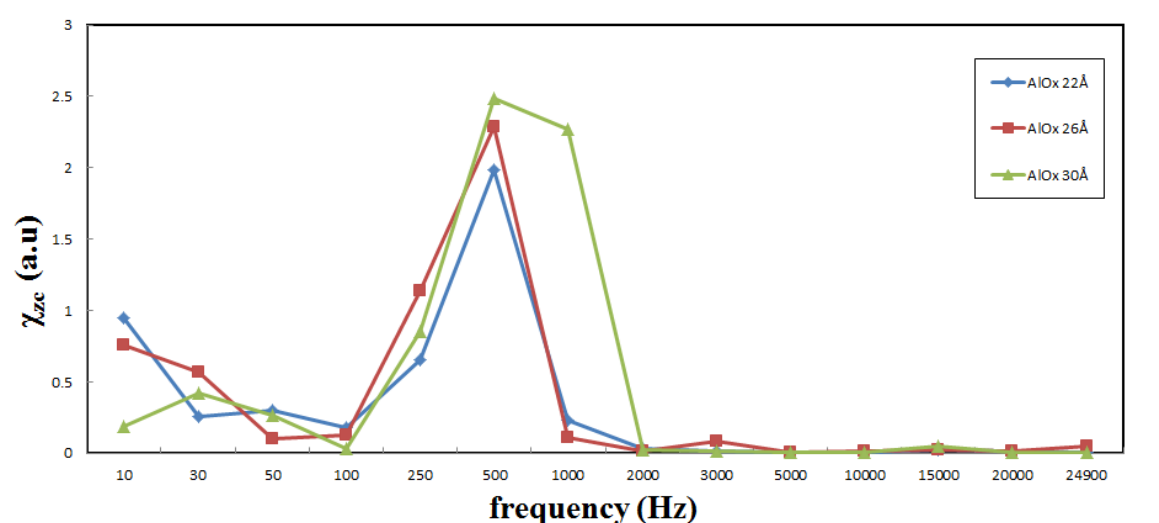
) of CoFeB/AlO ( d = 22, 26 and 30 Å)/Co MTJs as a function ac x